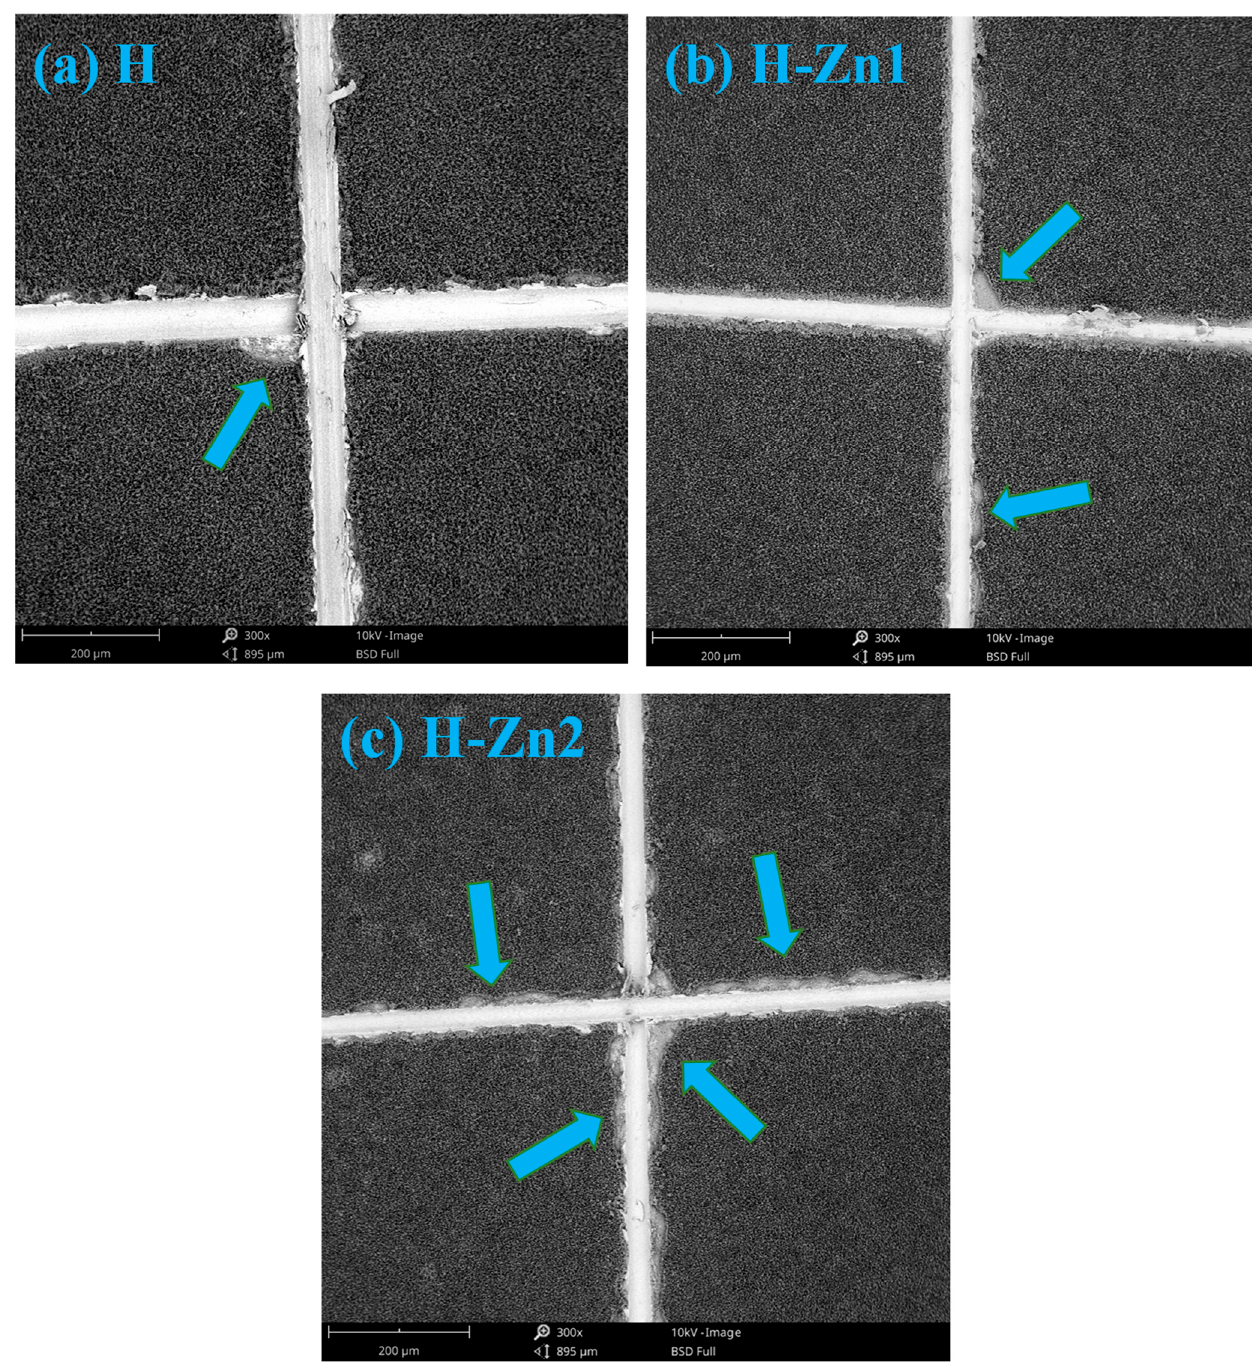
Figure 7. Representative SEM images of the ( a ) H, ( b ) H-Zn1, ( c ) H-Zn2 coatings after adhesion tests (blue color arow locate the delamination.